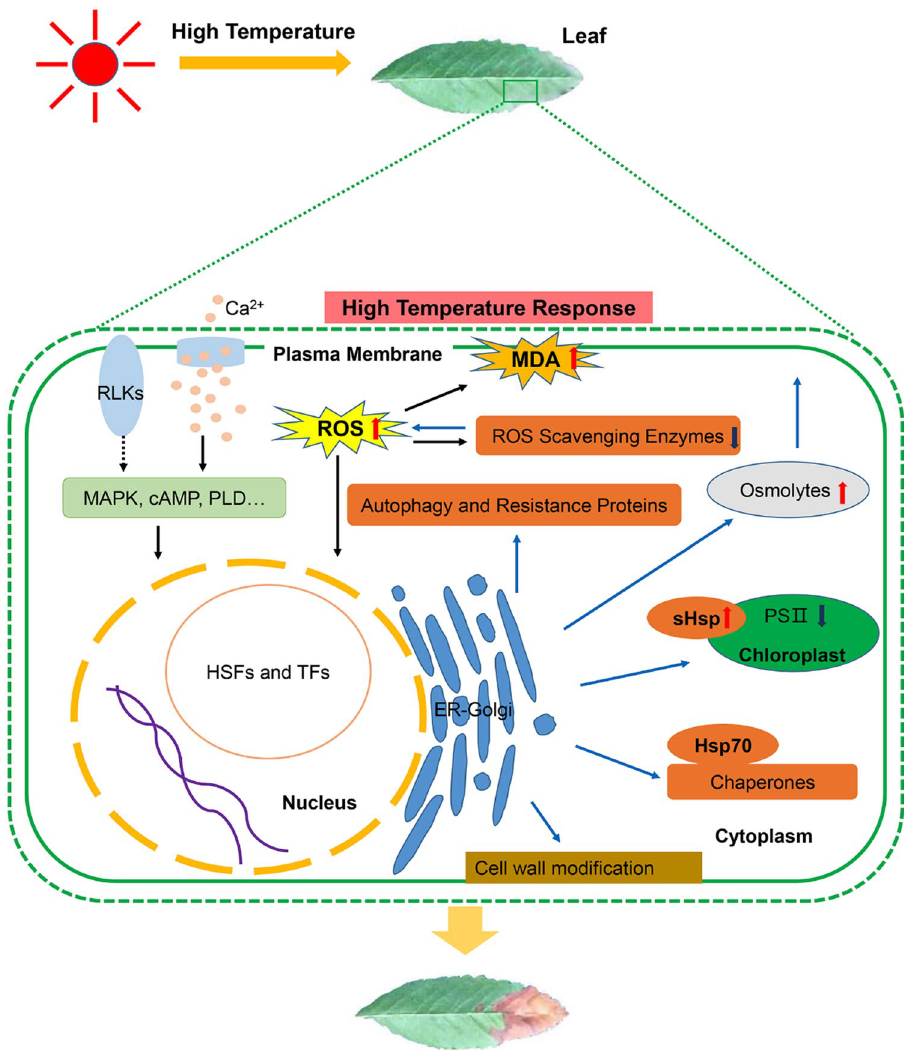
Figure 11. Schematic representation of the response mechanism of S. pohuashanensis to high temperature stress (Refer to Nishad et al. (2020) and Wang et al. (2020)) 20,22 . High-temperature stress causes damage to membrane proteins, denaturation and inactivation of various enzymes, and accumulation of reactive oxygen species. High-temperature stress changes membrane fluidity, which may be sensed by proteins, such as Ca 2+ channels and receptor-like kinases, localized at the plasma membrane. Calcium signaling plays critical roles in sensing sudden changes in temperature and activating cascades of signaling, leading to the production of Hsps that keep protein-unfolding under control. HSFs are the transcription factors that read the activation of thermosensors and induce the expression of HSPs. HsfAs are activated by high-temperature, and they target downstream transcription factors (such as HsfA3 ) to induce the expression of heat stress-responsive genes ( Hsp70 , sHsp , and other chaperones), which are important for ROS scavenging and protein homeostasis. In addition, some TF genes, including ERFs , bZIPs and ATHBs also play a role in the molecular mechanism of high-temperature stress in S. pohuashanensis . Accumulation of ROS in plants activates HSFs, which in turn activate ROS scavenging and detoxifying enzymes like APX and SOD. ROS level occurs due to the change by production of antioxidants, osmolytes, and Hsps. The major stress-responsive osmolytes in plants include proline, soluble-sugar and protein which play roles in maintaining cellular ionic